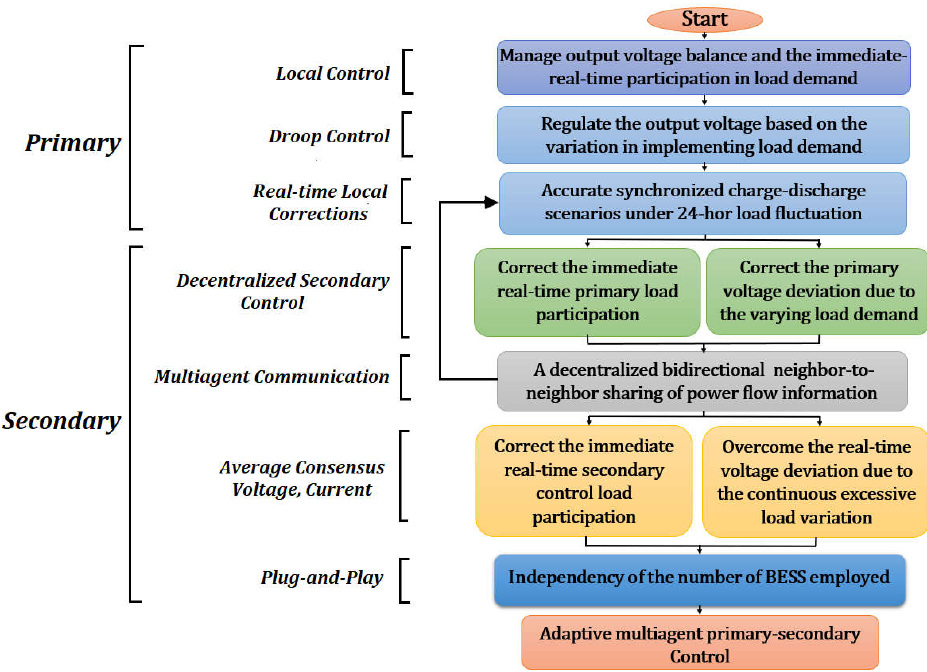
Figure 10. The methodological stages of designing the adapted multiagent primary–secondary control of BESS agents in DC autonomous microgrid.